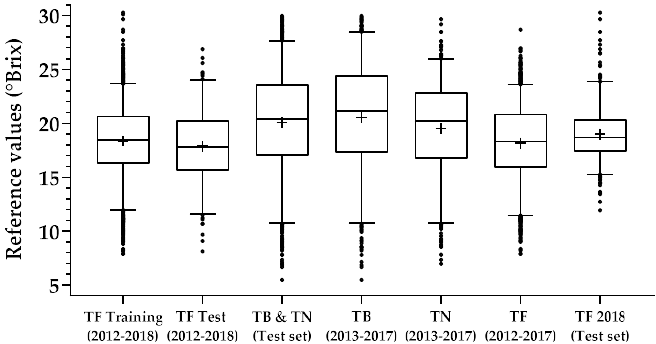
Figure A1. Boxplot of the descriptive statistics for sugar content reference values used for the training process and independent test phases. The boxes represent the 25th, 50th and 75th percentiles, the whiskers represent the fifth and 95th percentiles, the lower and upper open circles represent the minimum and maximum values, and the plus symbol denotes the mean values.